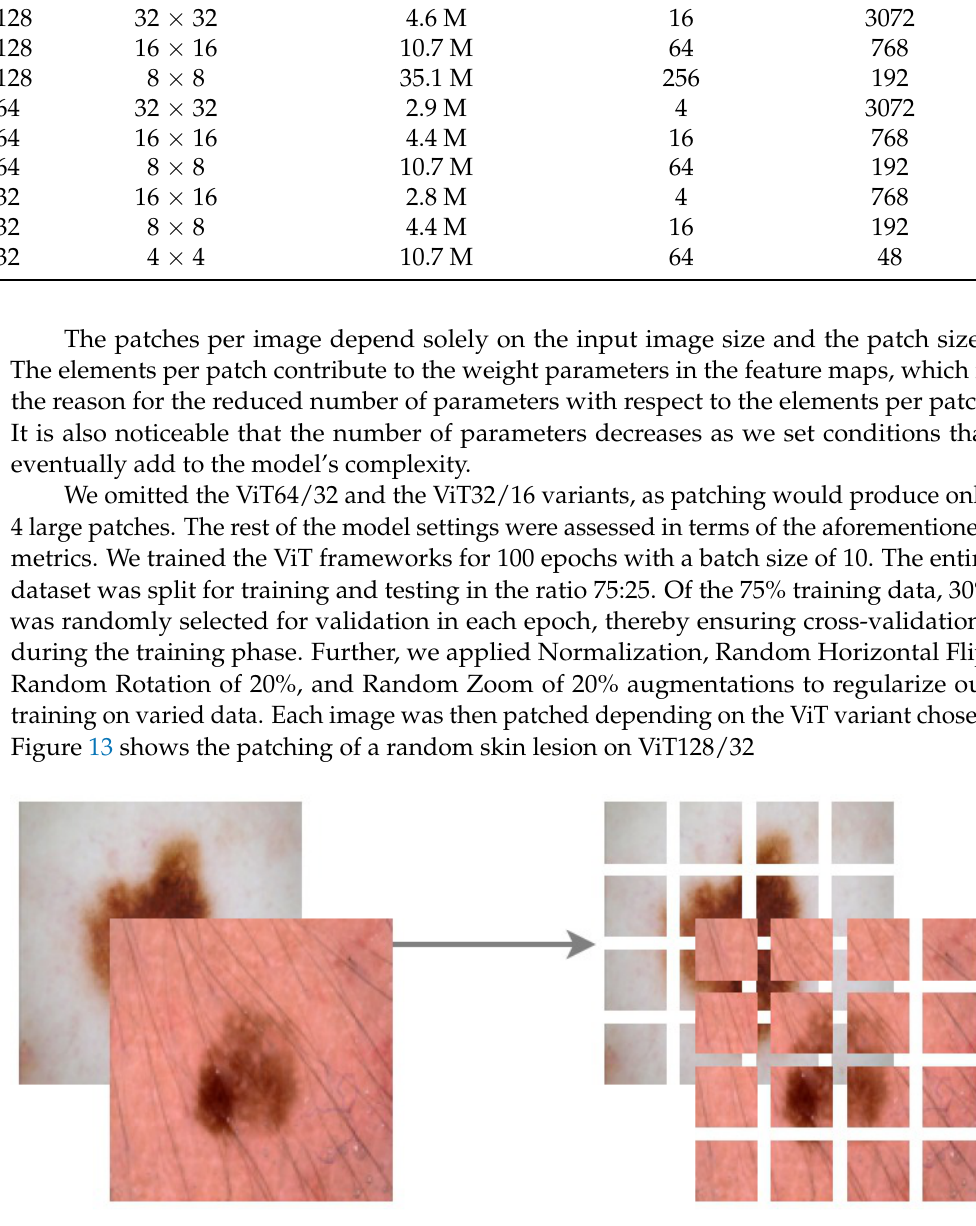
Figure 13. Patching Image size of 128 × 128 to 32 × 32